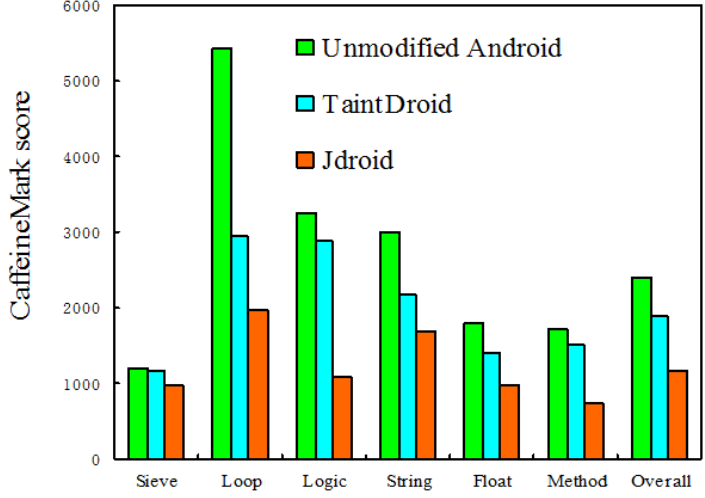
Figure 15. Microenchmark results.